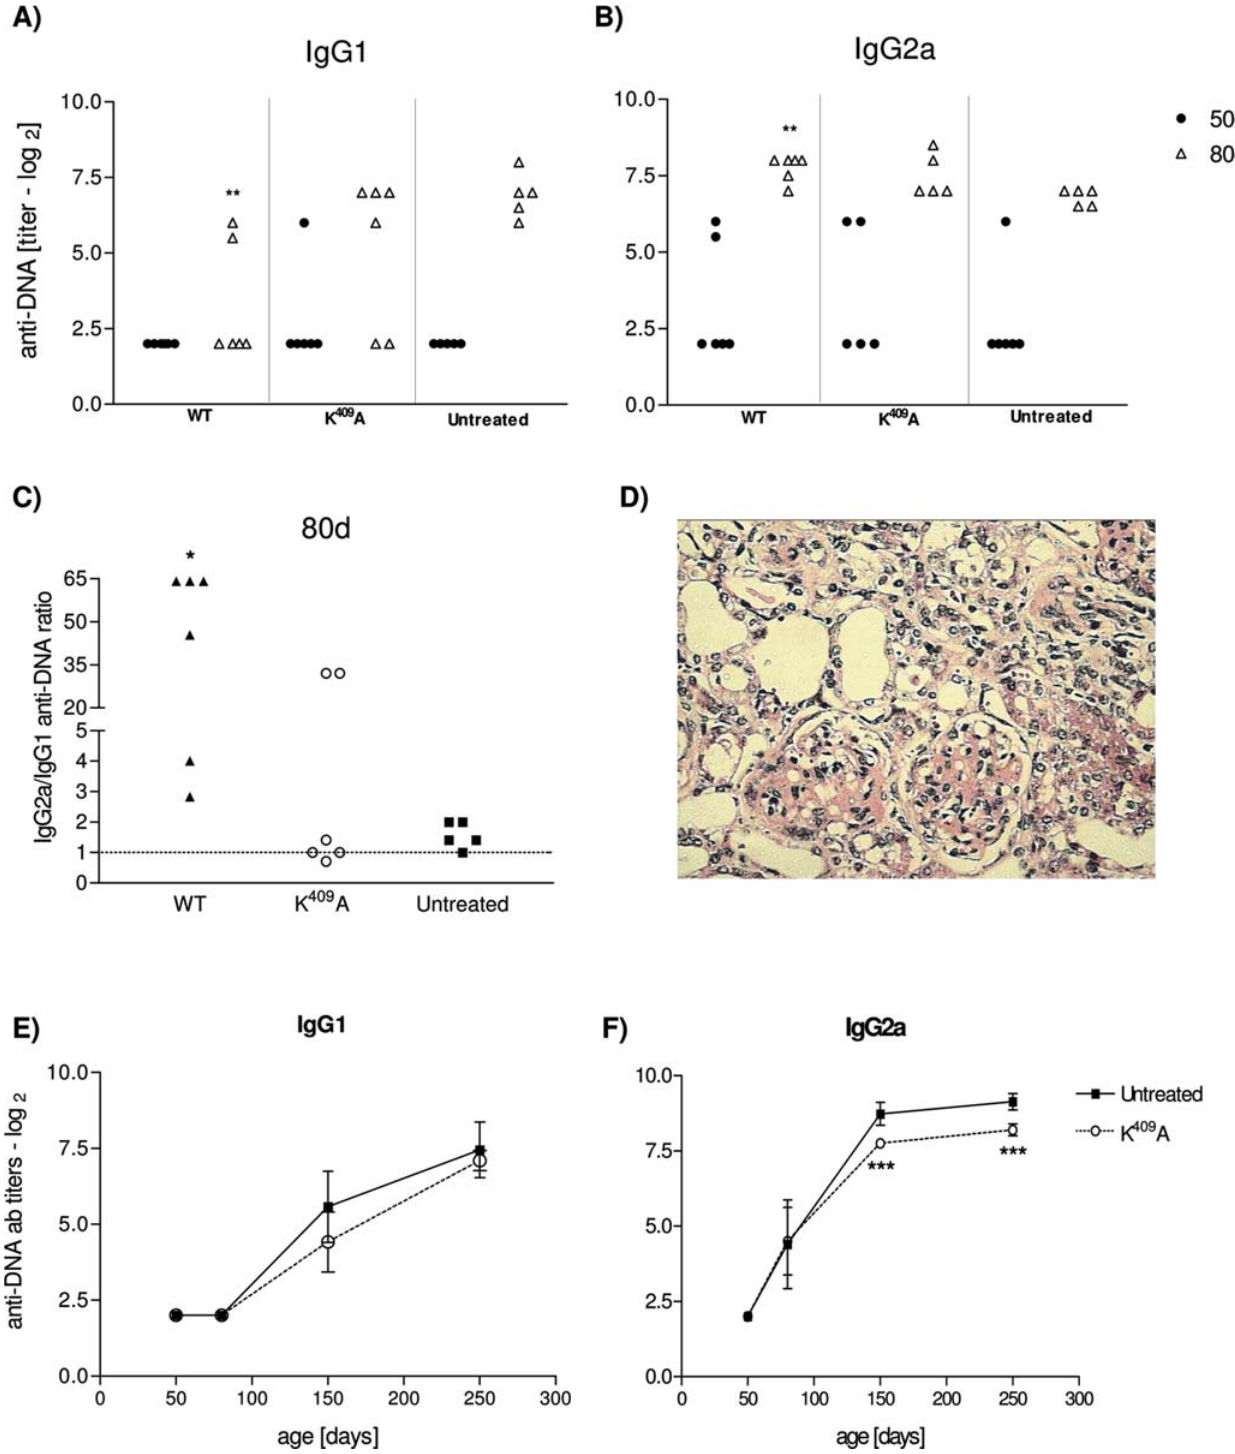
Figure 2. WT and K 409 A rHsp65 treatment in anti-DNA antibody response. Anti-DNA IgG1 [A] and IgG2a [B] isotypes antibody production and the IgG2a/IgG1 antibody ratio [C] in the serum of treated and untreated [NZBxNZW]F 1 mice [n=5–6/group]. Representative renal histological appearance from 4 to 5-month-old F 1 mice; light microscopy 100 6 [D]. Time-course production of anti-DNA IgG1 [E] and IgG2a [F] antibodies in untreated and K 409 A mice. Untreated group has been the reference group for unpaired t -test analysis; * p , 0.05; ** p , 0.01; *** p , 0.001. Results are representative of 3 independent experiments.